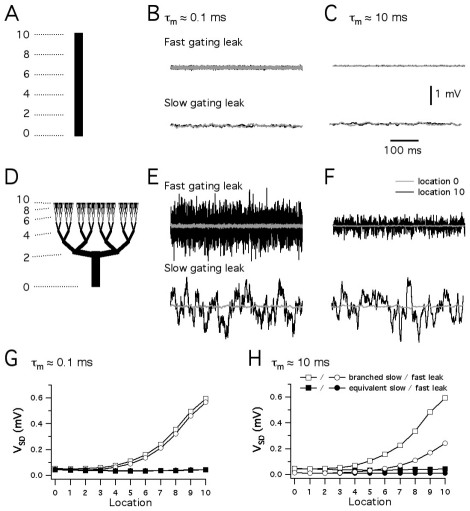
Dendrite morphology determines the influence of stochastic channel opening on membrane potential.(A–F) Recordings of resting membrane potential at proximal (grey traces) and distal (black traces) locations on a multi-compartmental model of a cylinder of length 320 µm and diameter 16 µm (A–C) or a hypothetical branched dendrite (D–F). The cylinder in (A–C) is electrically ‘equivalent’ to the dendrite in (D–F), which has a branching organization that follows Rall's 3/2 power law. The distal recordings are from location ‘10’ and the proximal recordings are from location ‘0’. In each panel the membrane potential when the leak channels have fast kinetics (upper traces) is compared to the membrane potential when the leak channels have slower kinetics (lower traces). Membrane potential when the models have a membrane time constant on the order of 0.1 ms (B,E) is compared to models with a membrane time constant on the order of 10 ms (C,F). The scale bars apply to all traces. (G–H) The standard deviation of the resting membrane potential of the models in (A–F) is plotted as a function of recording location. Each point is the average of data from 5 simulations of 1s of neuronal activity. The same data were used for statistical analysis (ANOVA). Black and grey symbols correspond to distal and proximal recording locations as in (A–F) above.